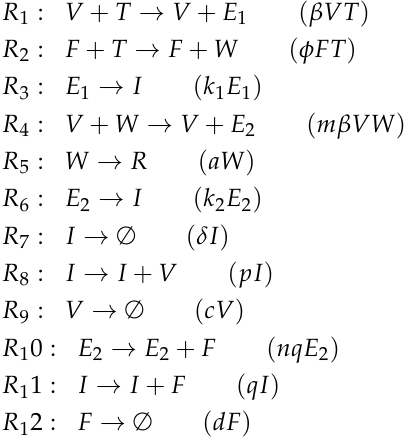
Figure A7. Reactions of Saenz model